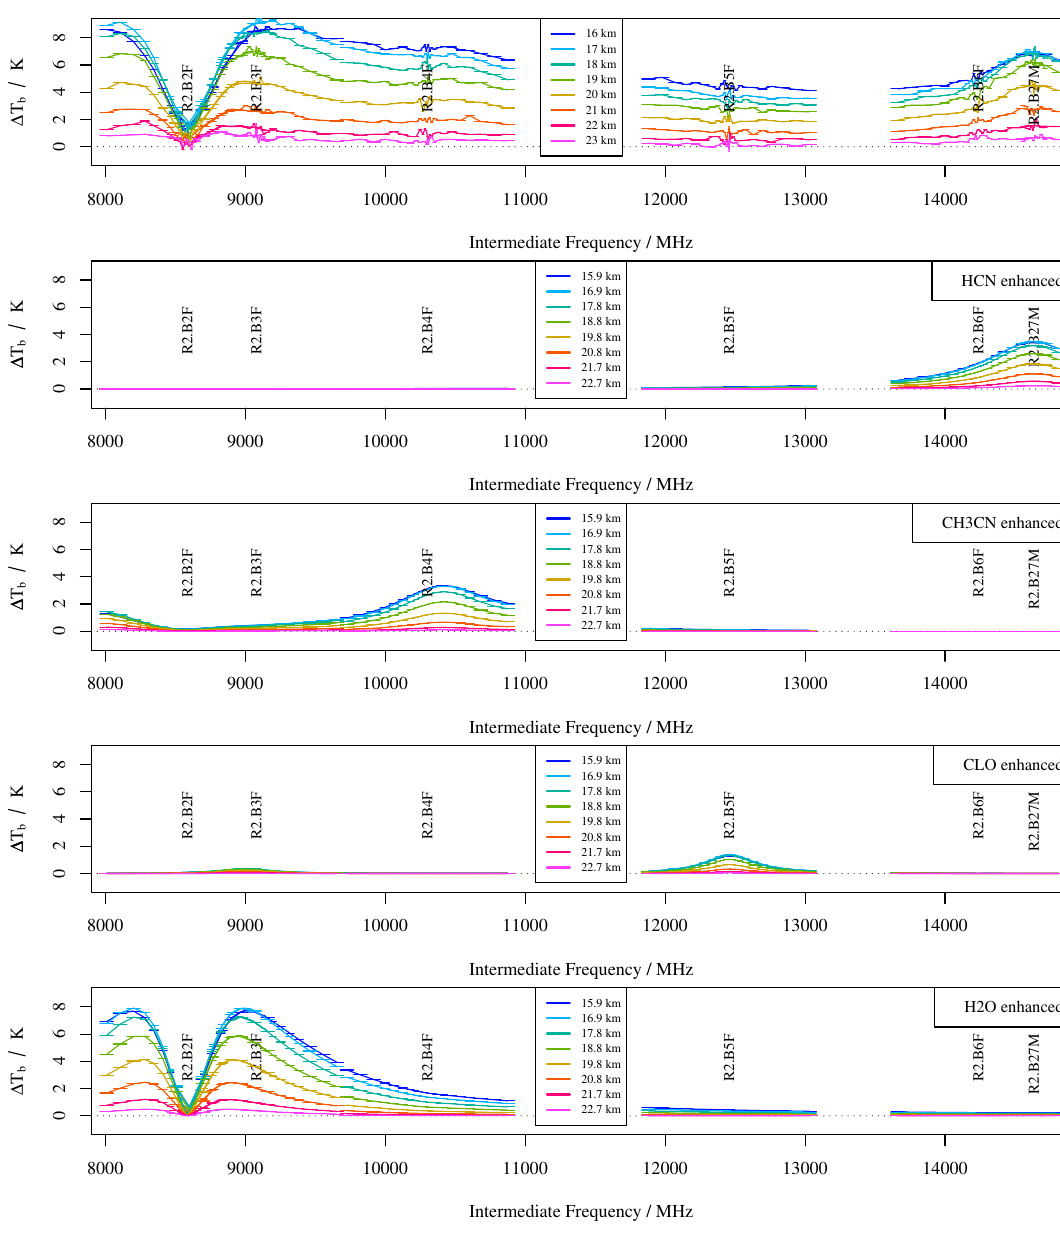
Fig. 7. Spectra from the 190GHz radiometer (R2) of MLS. The top panel is the measured difference between spectra in the plume and out of it. The other four panels show the difference between a default calculated spectrum and ones for which HCN, CH 3 CN, ClO and H 2 O are enhanced by roughly the amount observed in the retrieved profiles. If the top panel shows features similar to those in one of the other panels, this implies that the species which is enhanced in the calculation for the lower panel was also enhanced in the plume region. The vertical labels (e.g. R2.B5F) mark the centres of the individual filterbanks or “bands” which analyse the signal from this radiometer. Intermediate frequency is the difference between the frequency entering the instrument and the local oscillator frequency, which is 191.9GHz for R2; see Waters et al. (2006) for